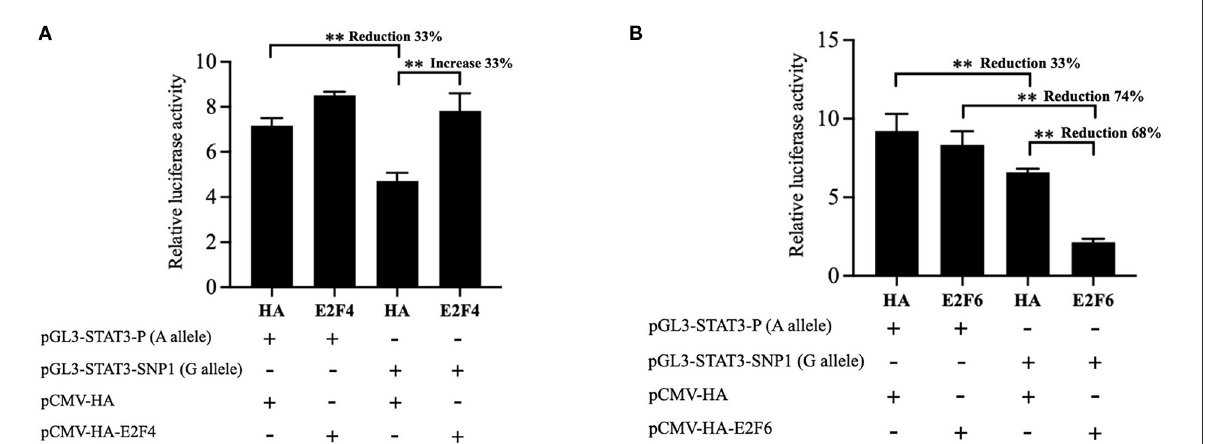
FIGURE4 Effect of E2F4 and E2F6 on transcriptional activity of STAT3 gene carrying SNP1. (A) IPEC-J2 cells were transfected with the luciferase reporter construct containing A or G at STAT3 SNP1 and E2F4 expression vector. (B) IPEC-J2 cells were transfected with the luciferase reporter construct containing A or G at STAT3 SNP1 and E2F46 expression vector. Relative luciferase activity was given as firefly activity over Renilla activity. Values are shown as the mean ± SD ( n = 3). ** P <